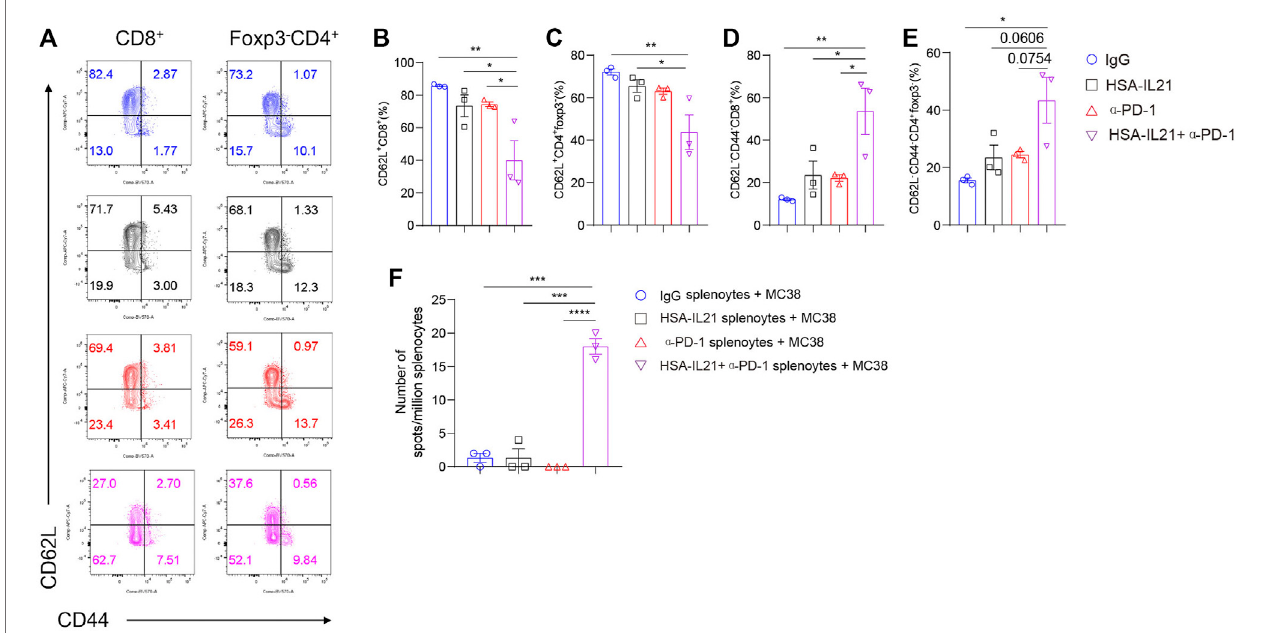
FIGURE 6 | Combination therapy promotes the tumor-antigen-speci fi c T cell response activation in peripheral lymphoid organs. (A – F) MC38 tumor cells (1 × 10 6 ) were injected intradermally to B6 mice, 9 days after tumor inoculation, MC38 tumor-bearing mice were treated with IgG, HSA-IL21, α -PD-1, HSA-IL21/ α -PD-1, 96 h later, immune cells from spleen were analyzed by fl ow cytometry. Splenocytes were applied to IFN- γ ELISpot assay. (A) Representative fl ow plots showing CD62L and CD44 staining on CD8 + and Foxp3 - CD4 + T cells in spleen. Quantitative expression of CD44, CD62L expression on T cells gated on CD8 + (B – D) and Foxp3 - CD4 + T cells (E) in spleen. Datawere presented as mean ± SEM, n (cid:2) 3, *p < 0.05, **p < 0.01, ***p < 0.001 , one-way ANOVA test wasperformed. (F) Numbers of tumor- antigen speci fi c IFN- γ producers in the splenocytes. Data were presented as mean ± SEM, n (cid:2) 3, *p < 0.05, **p < 0.01, ***p < 0.001 , one-way ANOVA test was